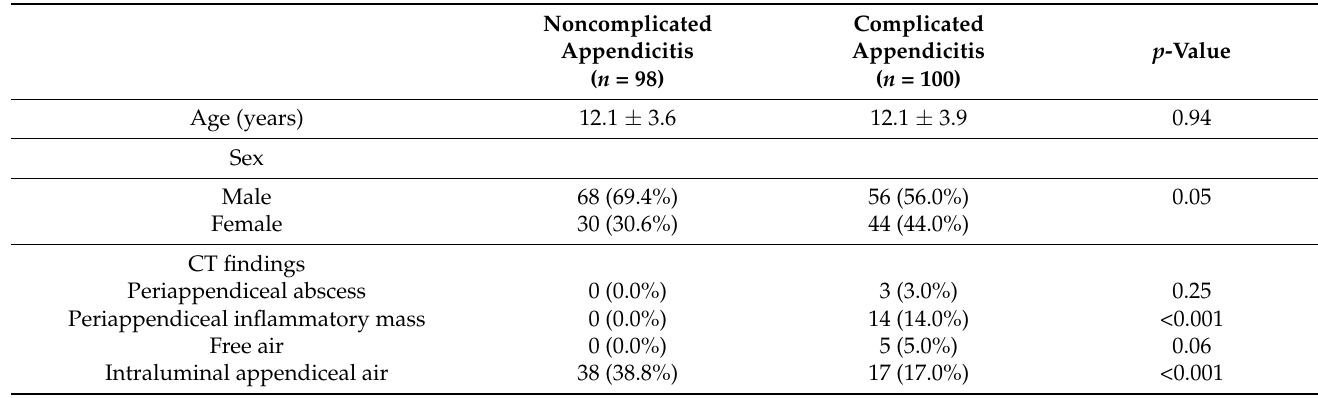
Table 2. Comparison between Noncomplicated and complicated appendicitis in development